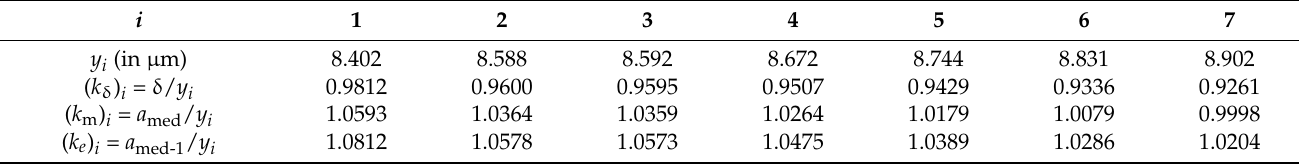
Table 10. Values of the proportionality coefficients ( k δ ) i , ( k m ) i and ( k e ) i for a column (simple geometric